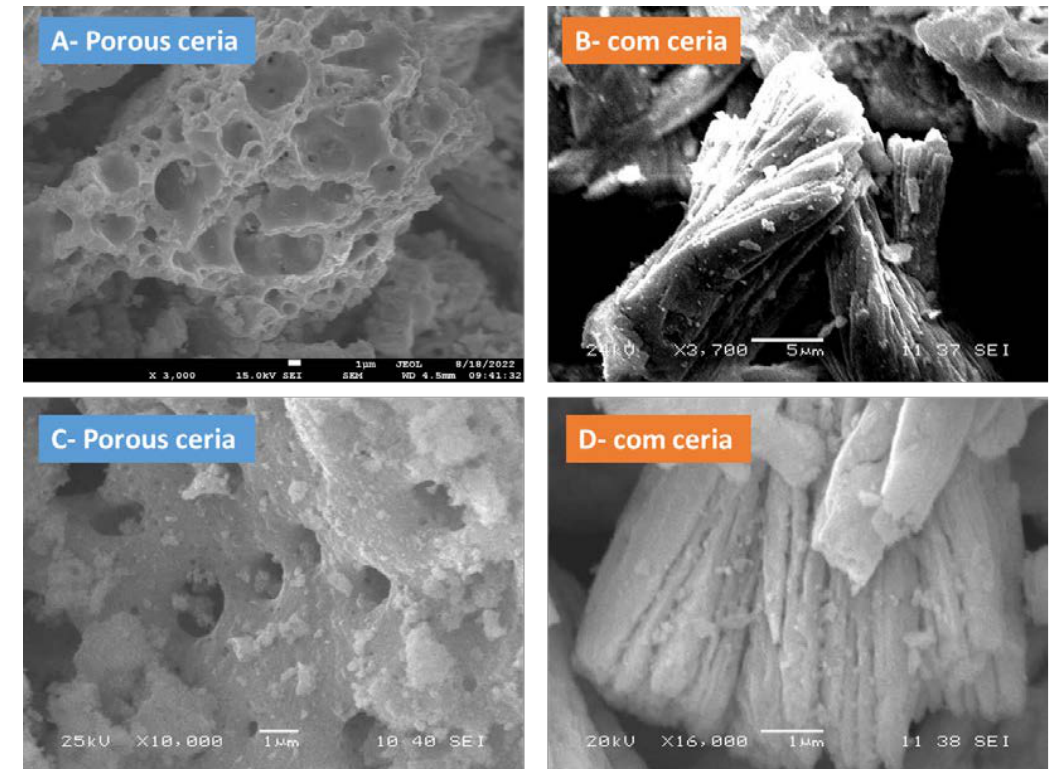
Figure 4. The SEM micrographs of the porous ceria sample ( A and C ) and the commercial ceria sample ( B and D ).